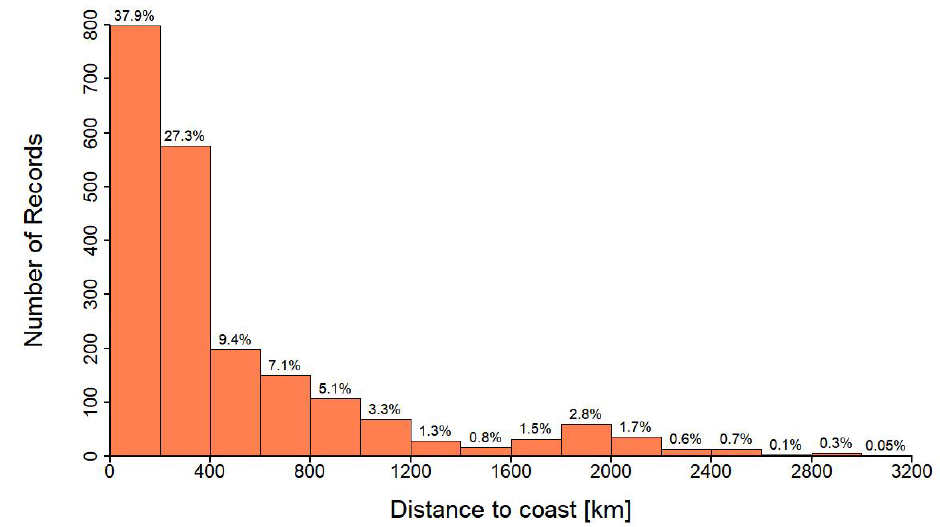
Figure 2. Number of isotope records available in this atlas versus distance to the coastline in 200km bins. The global coastline was created with the free vector and raster map data from http://www.naturalearthdata.com (last access: 19 May